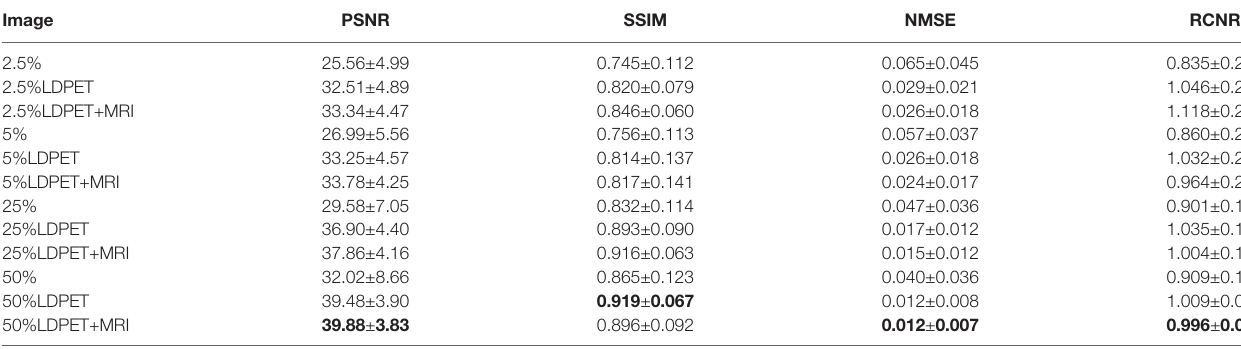
FIGURE 2 | NMSE and SSIM of the original LDPET images, synthetic FDPET images, and MR prior-synthesized FDPET images at all doses, where blue represents SSIM, orange represents NMSE, and different degrees of color represent images of different doses.